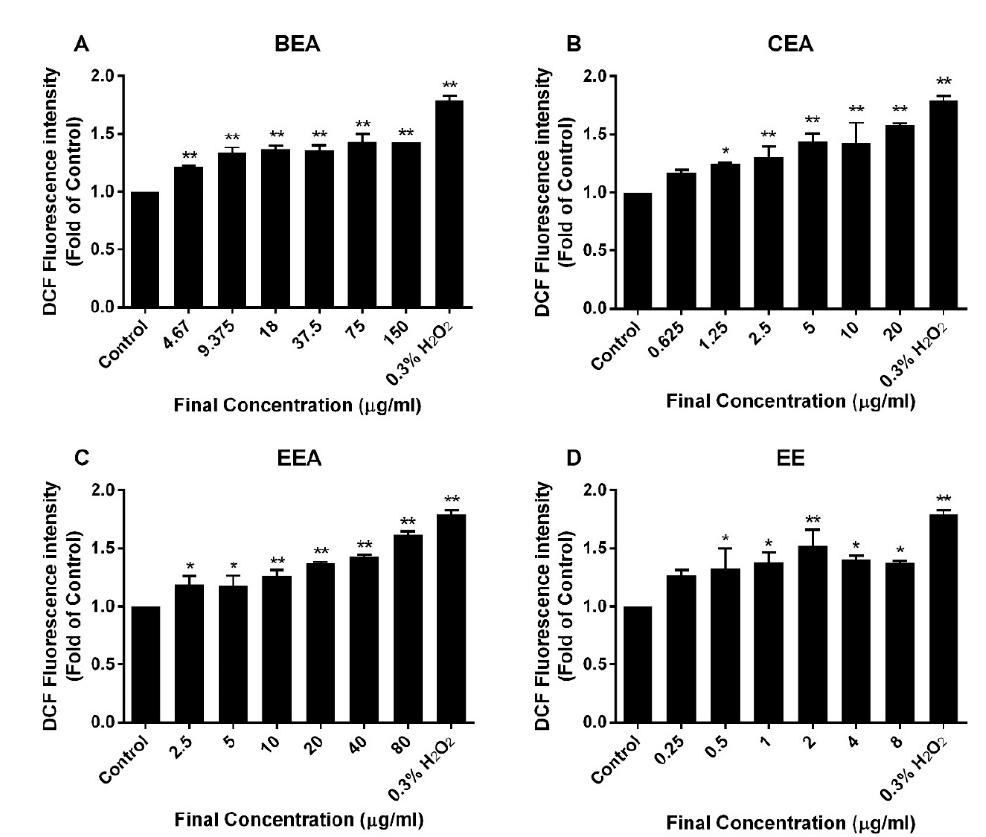
Figure 8. ROS generation in A549 cells after treatment with the effective extracts. The level of intracellular ROS was determined by DCFH-DA fluorescence dye. The increase of fluorescence intensity, which indicates that ROS are generated, is shown on the bar graphs after treatment with ( A ) BEA, ( B ) CEA, ( C ) EEA, and ( D ) EE for 4 h. H 2 O 2 0.3% was used as a positive control for ROS production. The data were a mean ± SD of three independent experiments carried out in duplicate, * p < 0.05, ** p < 0.01 with respect to the control condition.